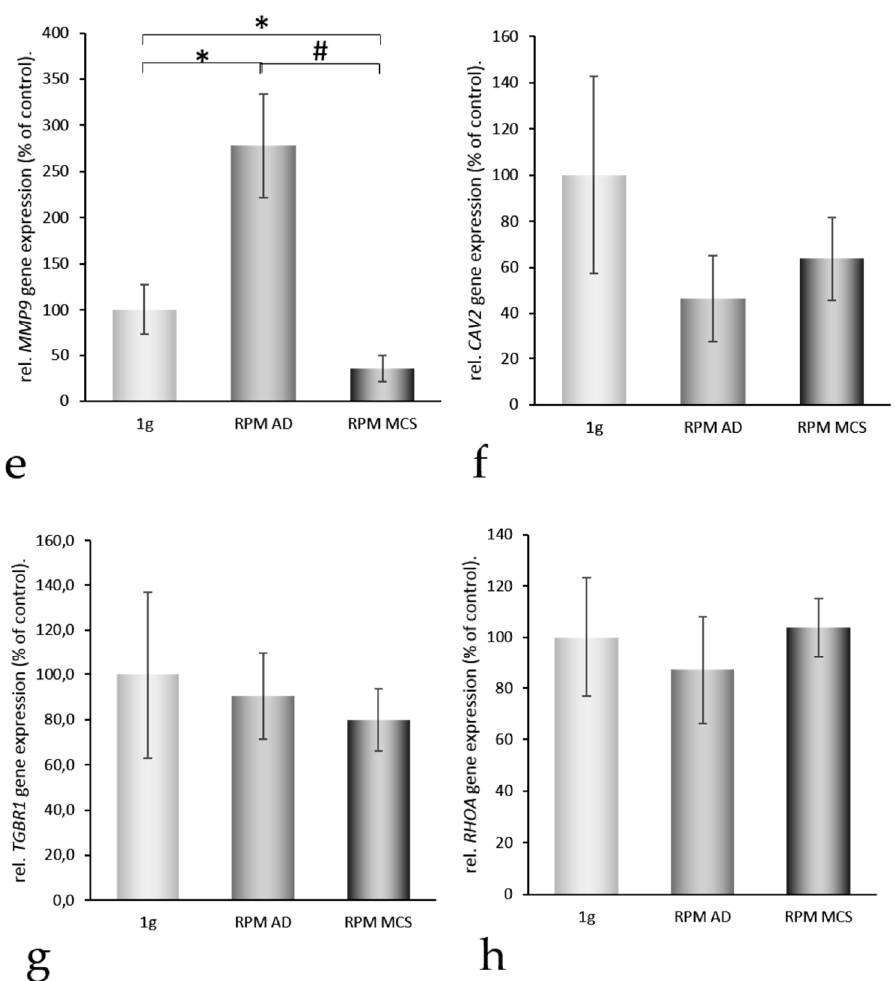
Figure 5. Quantitative real-time PCR of genes of interest III. After 24 h, 1g-control, RPM-adherent (AD) and RPM-multicellular spheroids (MCS) were analyzed for their MMP3 ( a ); CAV1 ( b ); TBFB1 ( c ); PAI1 ( d ); MMP9 ( e ); CAV2 ( f ); TGFBR1 ( g ) and RHOA ( h ) gene expression levels. * = p < 0.05 vs. 1g; # = p < 0.05 vs. RPM AD.